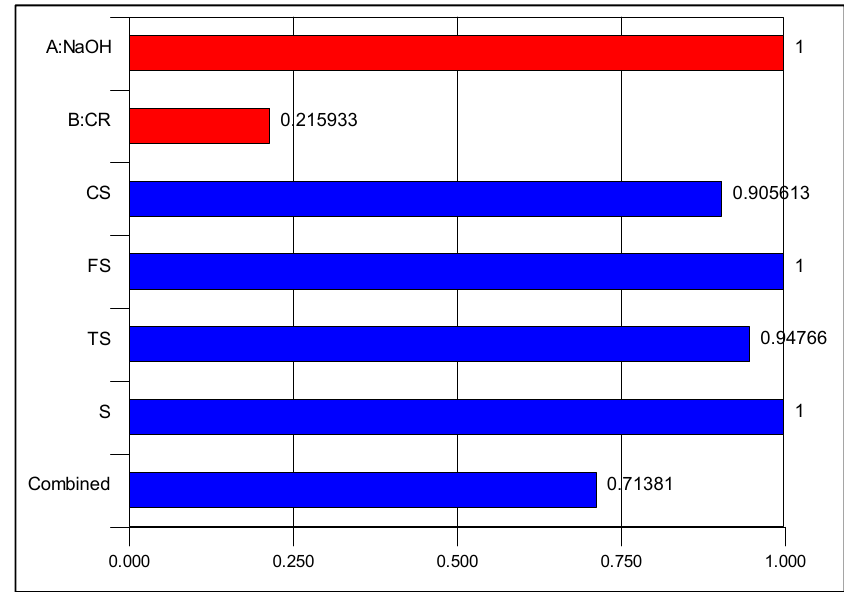
Figure 17. Desirability.